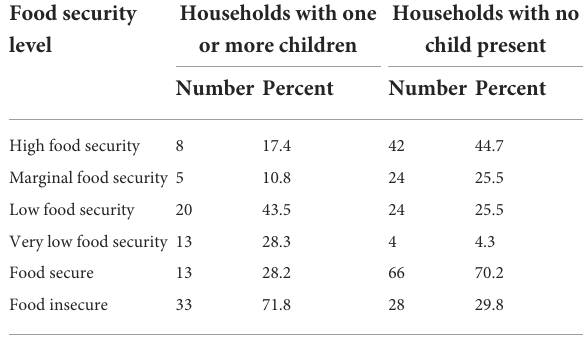
TABLE 4 The status of food security for households with and without child.